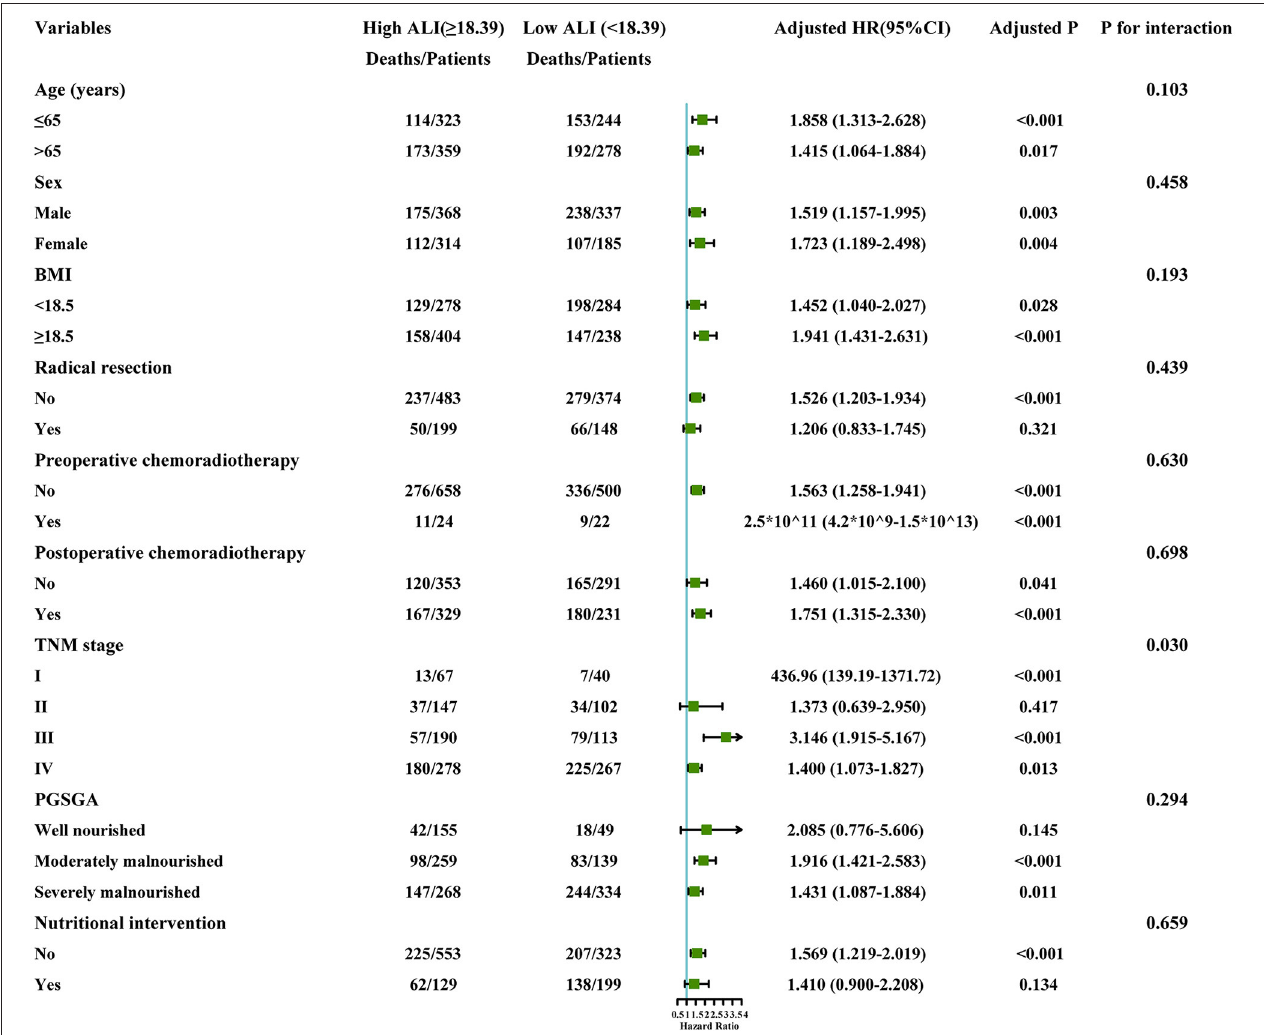
FIGURE 5 | The stratification analysis of the ALI. Adjusted for model 2: Age, Sex, Radical resection, TNM stage, EORTC QLQ-C30, KPS, Neoadjuvant chemoradiotherapy, Post-operative chemoradiotherapy, Lymphocytes, Neutrophils, WBC, AST, ALT, Serum albumin, Comorbid disease (s), Family history of cancer, Tea consumption, Alcohol consumption, Smoking, Platelet, Hemoglobin, Serum total protein, PGSGA, Nutritional intervention, 30-day death, HGS. ALI, Advanced Lung Cancer Inflammation Index; WBC, White Blood Cells; AST, Aspartate Aminotransferase; ALT, Alanine Transaminase; HGS, Hand grip strength; BMI, Body